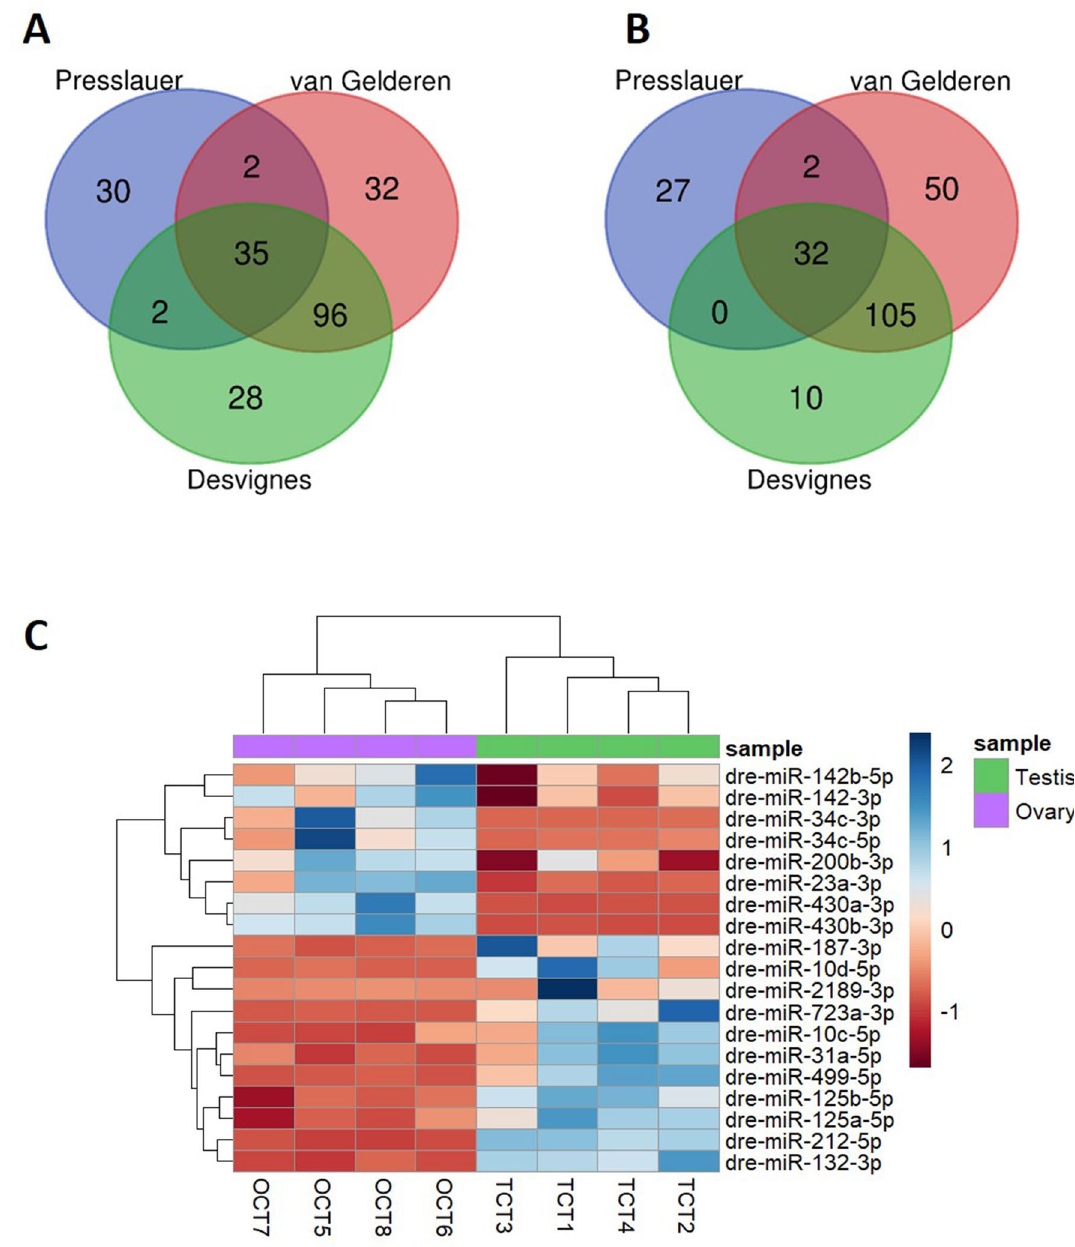
Figure 1. The number of miRNAs that were significantly expressed (average normalized reads > 100) of two AB strains (current data and Desvignes et al. 18 ) and zf45Tg hybrid zebrafish (Presslauer et al. 47 ). ( A ) In ovaries, and ( B ) testes. ( C ) Heatmap of differentially expressed miRNAs between ovary and testis commonly found in Desvignes et al. 18 and present